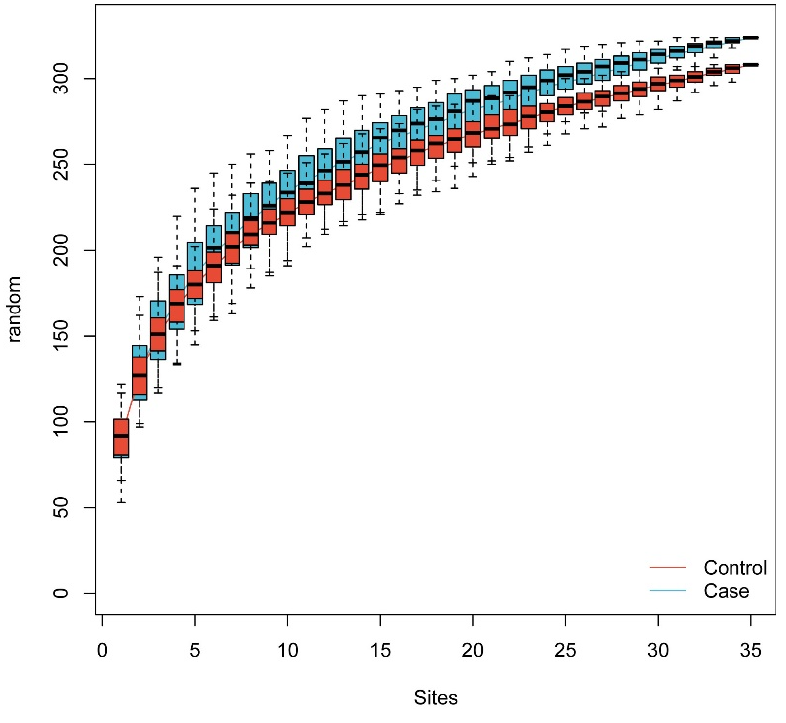
Figure 1. Rarefaction curve.